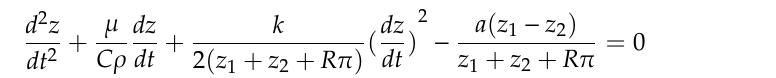
Figure 4. The simulation displacement-time curve of the switch.